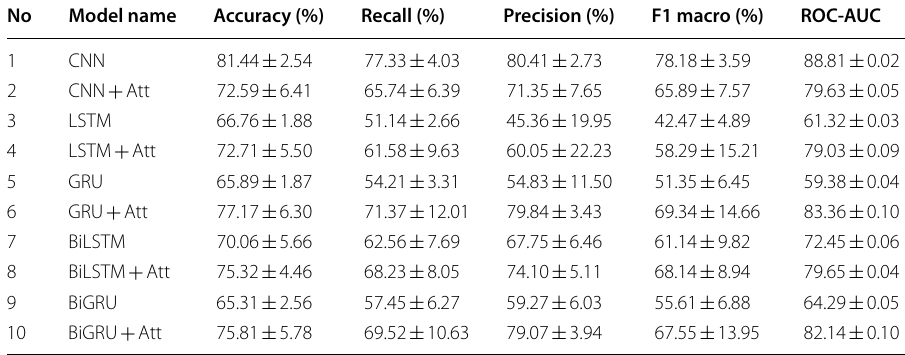
Table 5 Result of argument analysis using deep learning model with attention mechanism (Word Embedding from Scratch)